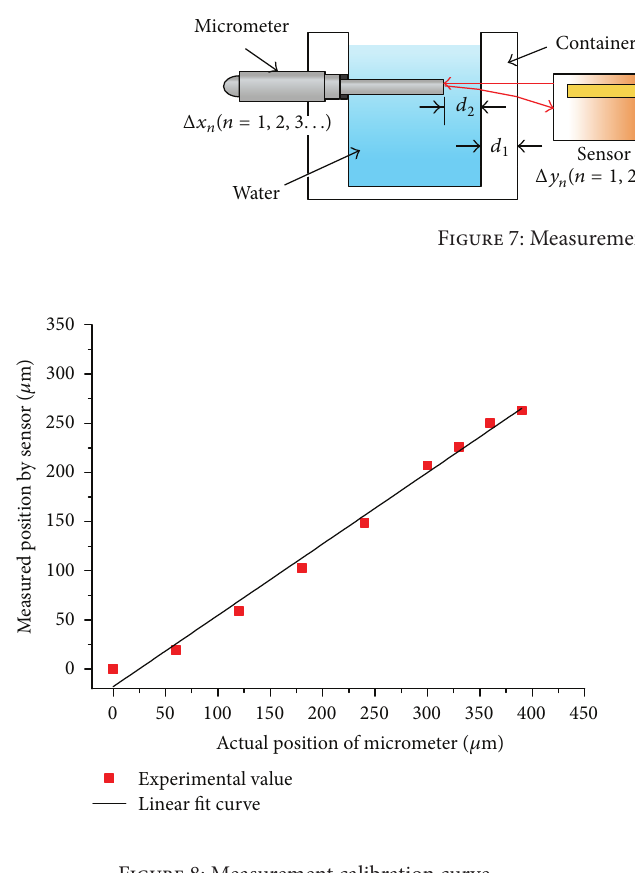
Figure 8: Measurement calibration